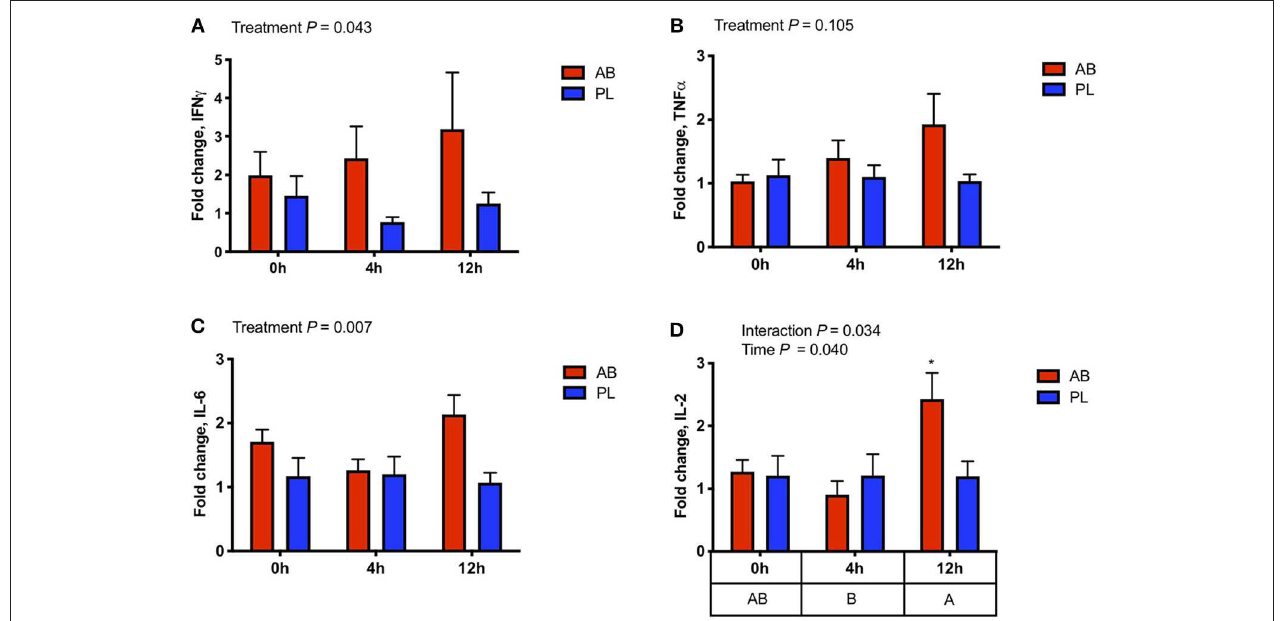
FIGURE 3 | Gene expression of effector cytokines in whole blood was altered 0, 4, and 12h post intraperitoneal Salmonella challenge in pigs treated with antibiotics (AB) vs. placebo (PL) as analyzed by a Two-way ANOVA (A) IFN γ expression was higher in AB vs. PL treated pigs (Treatment P = 0.043, Time P = 0.715, Interaction P = 0.647). (B) TNF α expression tended to be higher with AB treatment (Treatment P = 0.105, Time P = 0.192, Interaction P = 0.338). (C) IL-6 expression was also higher in AB vs. PL treated pigs (Treatment P = 0.007, Time P = 0.312, Interaction P = 0.125). (D) There was an interaction between time and treatment on the expression of IL-2 and was increased in AB treated pigs 12h post-challenge compared to AB and PL treated pigs at all time points as indicated by an asterisk (Treatment P = 0.186; Time P = 0.040, Interaction P = 0.034) n = 7/treatment. The main effect of time is displayed below the figure and those time points not sharing a common letter differ significantly. Post-hoc pair-wise comparisons made with Bonferroni